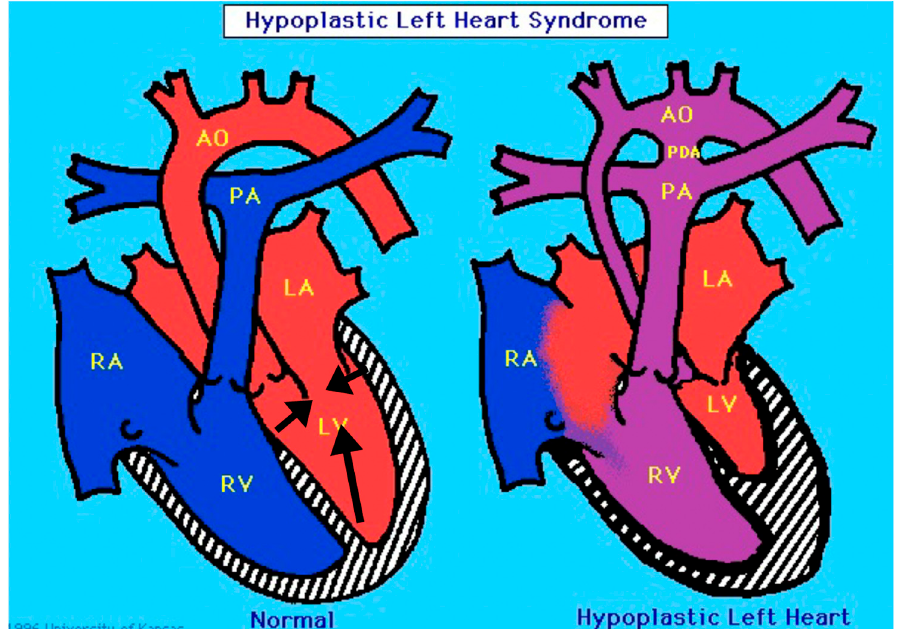
Figure 5. Schematic diagram model for one potential mechanism for the aortic atresia/mitral stenosis anatomic subtype of HLHS, indicating “concentric hyperplasia”, i.e., inward growth of cardiac myocytes leading to a thickened ventricular wall and diminutive chamber volume.